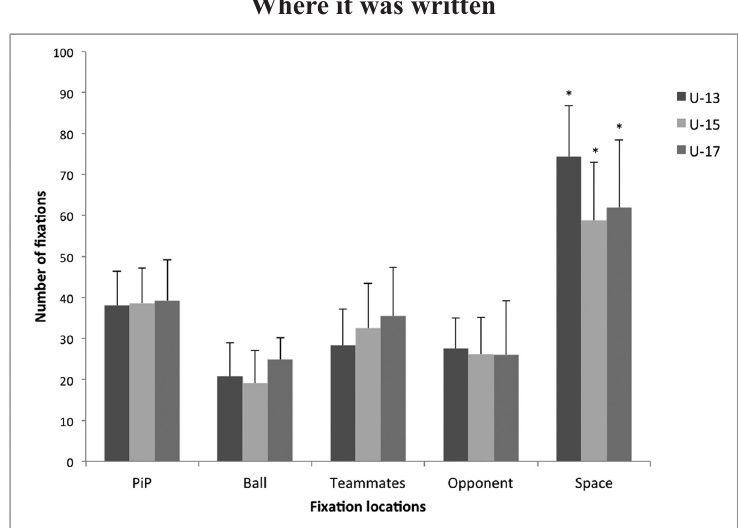
Figure 2. Means and standard deviation for the time of fixations made by each group in pre-defined locations in the video sequences